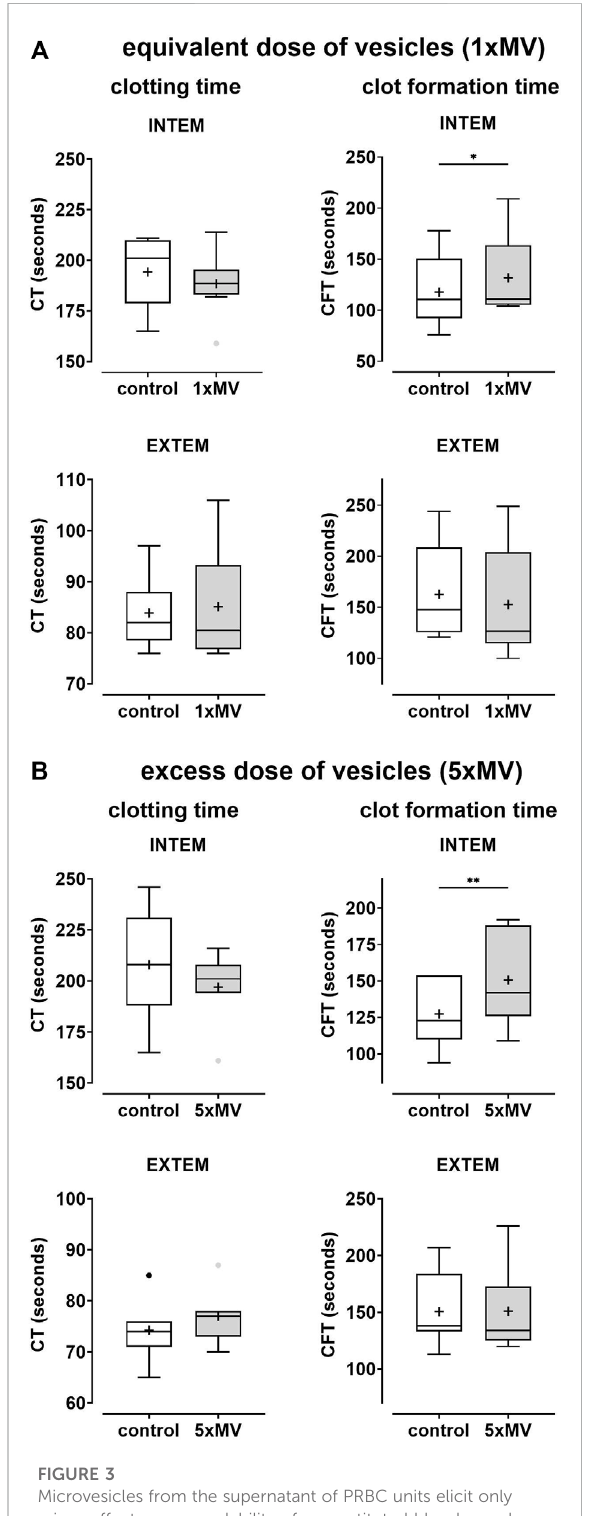
FIGURE 3 Microvesicles from the supernatant of PRBC units elicit only minor effects on coagulability of reconstituted blood samples. Microvesicles (MVs) isolated from the supernatant of PRBC units. Platelet-rich plasma (PRP) was prepared from freshly drawn blood samples and fractions (5% or 25%) of the PRP were